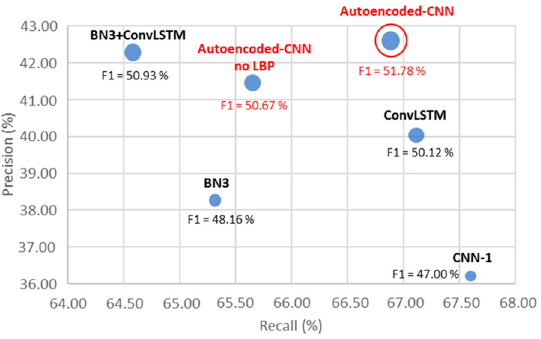
Figure 13. Precision versus recall versus F1-score bubble scatter plot for model comparison.